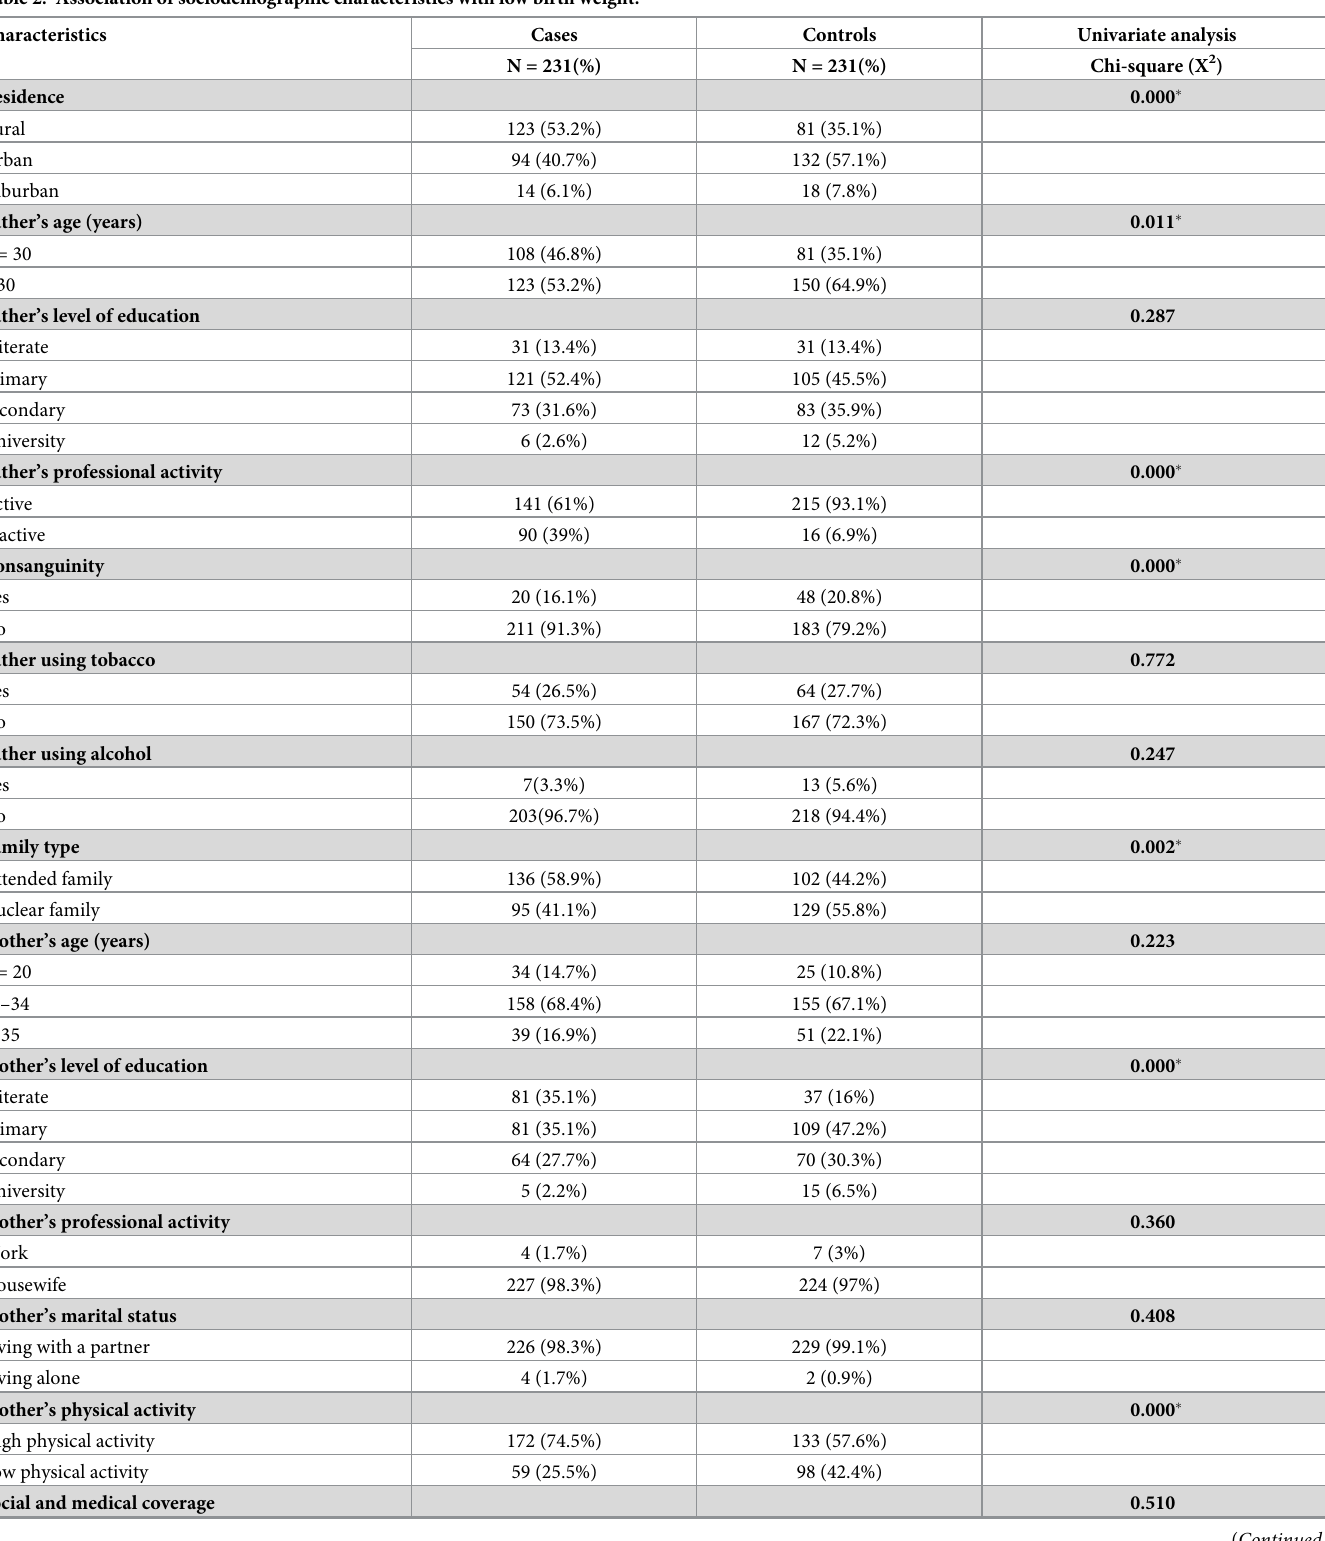
Table 2. Association of sociodemographic characteristics with low birth weight.